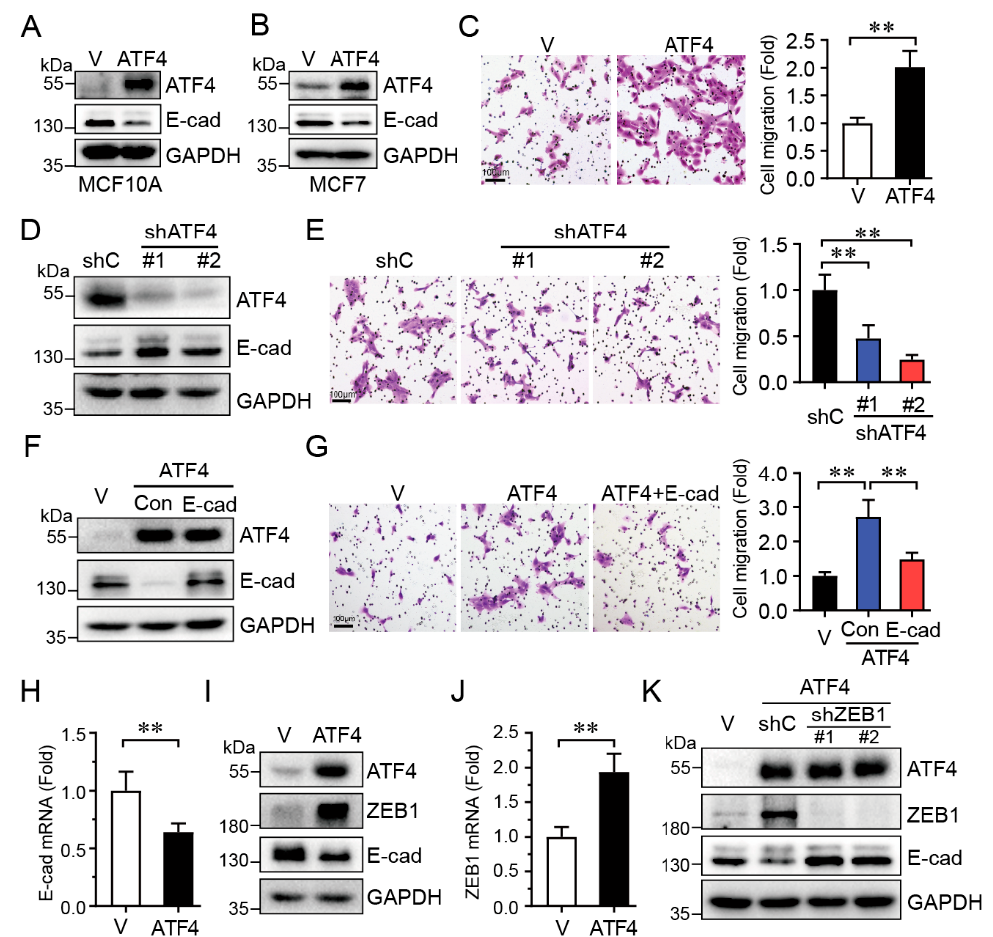
Figure 3. ATF4 promotes cell migration via suppression of E-cadherin expression. MCF10A-ATF4 cells were subjected to Western blot analyses ( A , I ), transwell assays ( C ), and Q-PCR assays ( H , J ). MCF7-ATF4 cells were subjected to Western blot analyses ( B ). MCF10A cells stably expressing specific shRNA targeting ATF4 or a control (shC), were subjected to Western blot analyses ( D ) or transwell assays ( E ). ( F , G ) MCF10A-ATF4 cells infected with a lentivirus expressing E-cadherin were subjected to Western blot analyses (F) or transwell assays (G). MCF10A-ATF4 cells infected with a lentivirus expressing shZEB1-#1, shZEB1-#2 or a control (shC), were subjected to Western blot analyses ( K ). Data were analyzed from three independent experiments and were presented as means ± SD; scale bars: 100 µ m; **: p < 0.01.